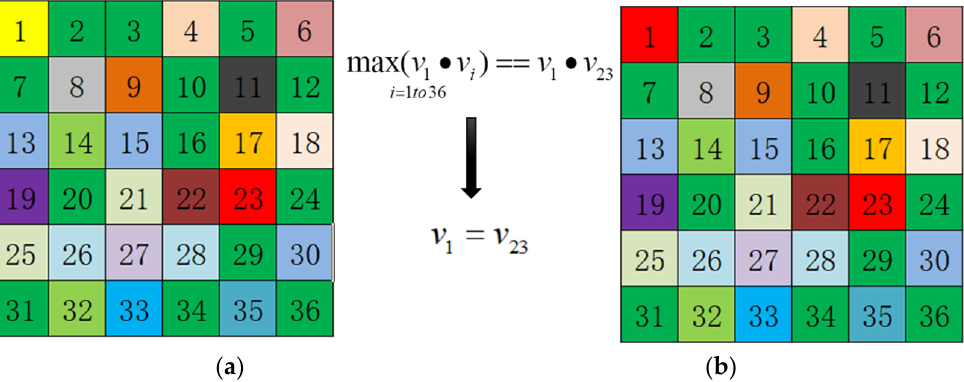
Figure 2. Schematic diagram of contribution weight of two-dimensional tokens.